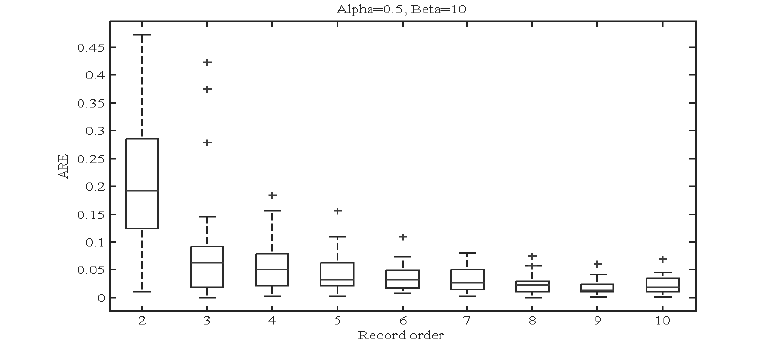
Figure 3 – Skewness coefficient of records.